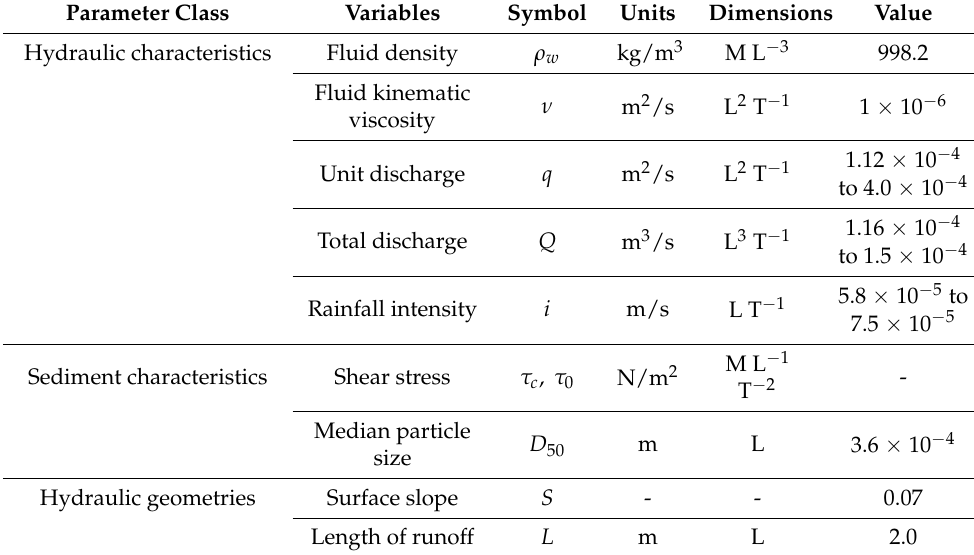
Table 4. List of selected